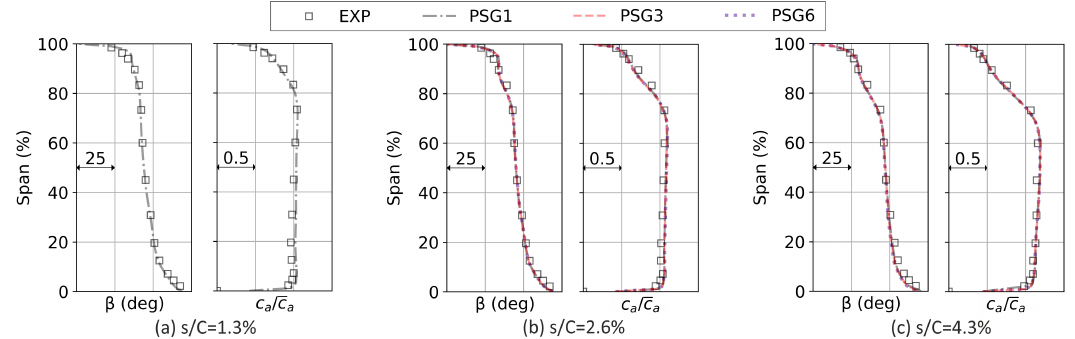
Figure 5. Radial distributions of circumferential-averaged flow parameters at MP out ( Φ = 0.50 for s / C = 1.3% and 2.6%; Φ = 0.51 for s / C =